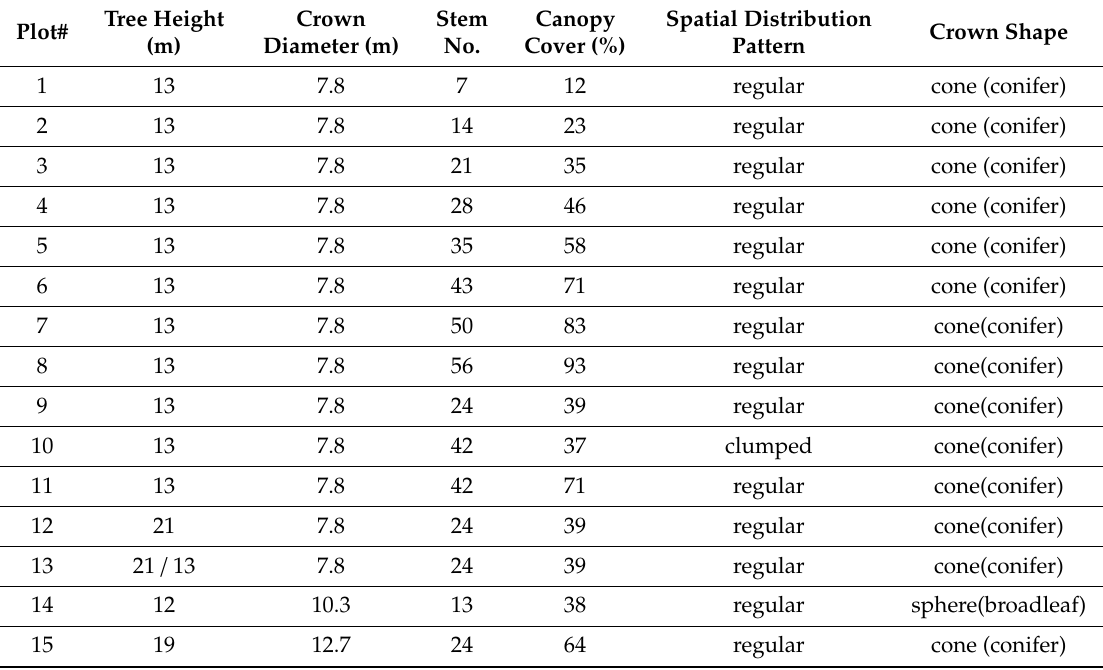
Table 2. Characteristics of 15 modeled forest plots based on aerial laser scanning data